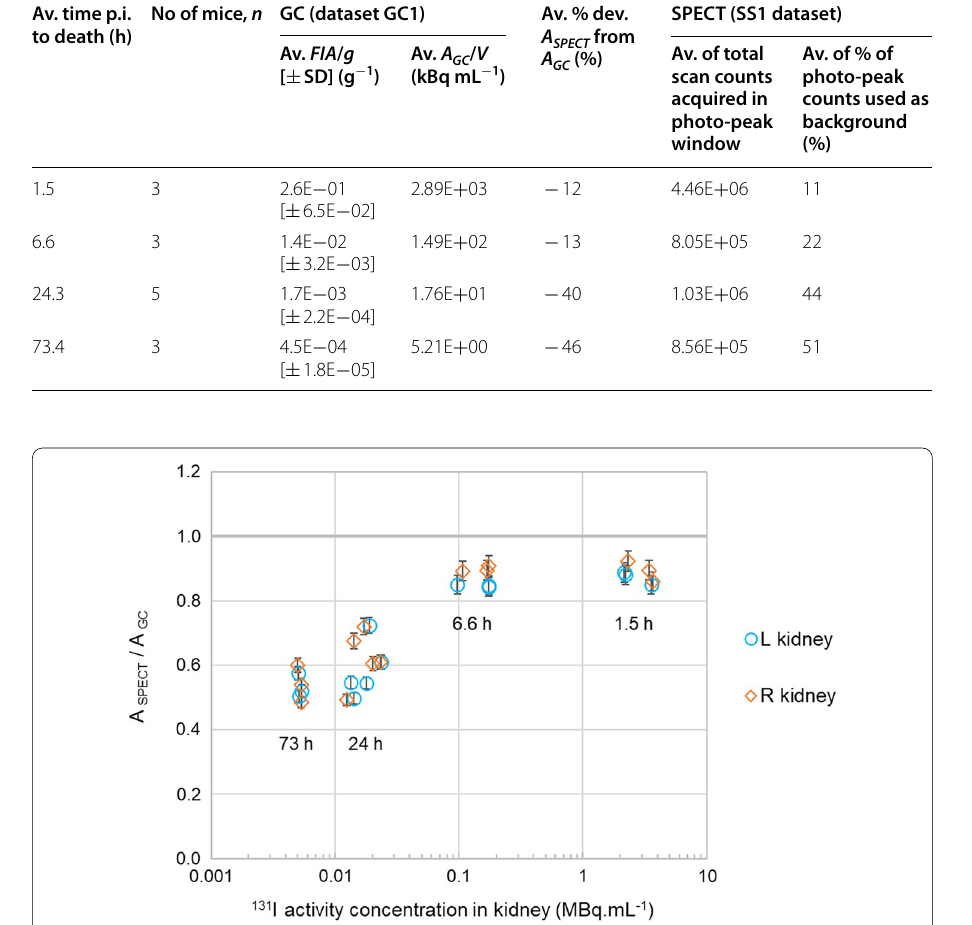
Fig. 8 Ratios between the 131 I activity in the kidney determined with SPECT ( A SPECT ) and the reference activity determined with GC ( A GC ) as a function of the reference activity concentration in the kidney ( A GC / V ), for all mice ( n 14) of datasets GC1 and SS1. Each data symbol corresponds to one kidney of one mouse. Labels = indicate the approximate time point of the pharmacokinetic profile to which a group of data symbols belong. Error bars indicate the expanded combined uncertainty of only GC measurements, U GC , at the 95.5% ±